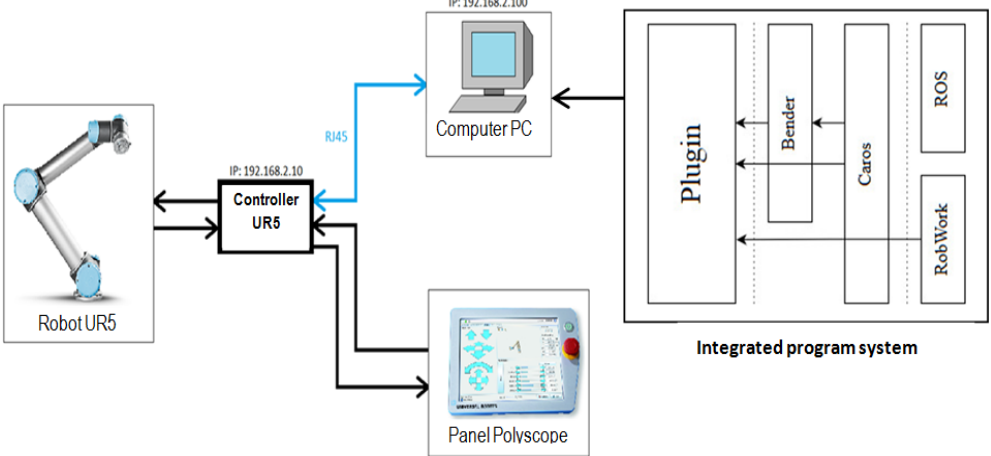
Figure 8. Subsystems interactions of laboratory setup in a ‘pick ‐ and ‐ place’ process performed by UR ‐ 5. UR-5.